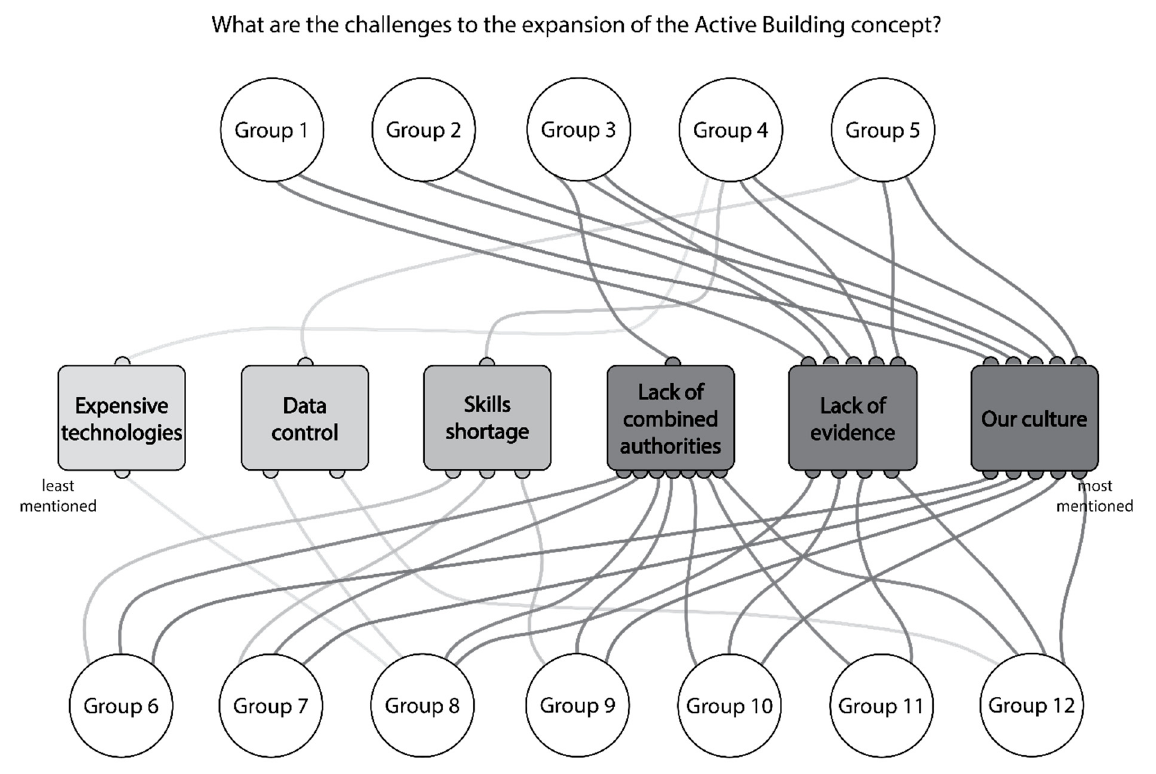
Figure 5. Challenges to the dissemination of active buildings according to different groups of stake ‐ holders.